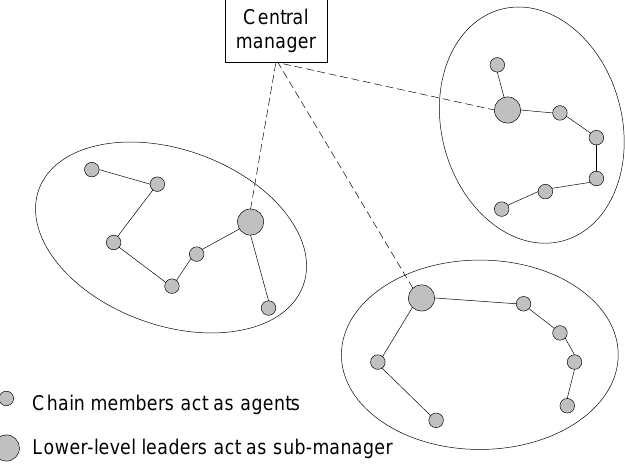
Figure 21. Different entities of the network management scheme for the proposed